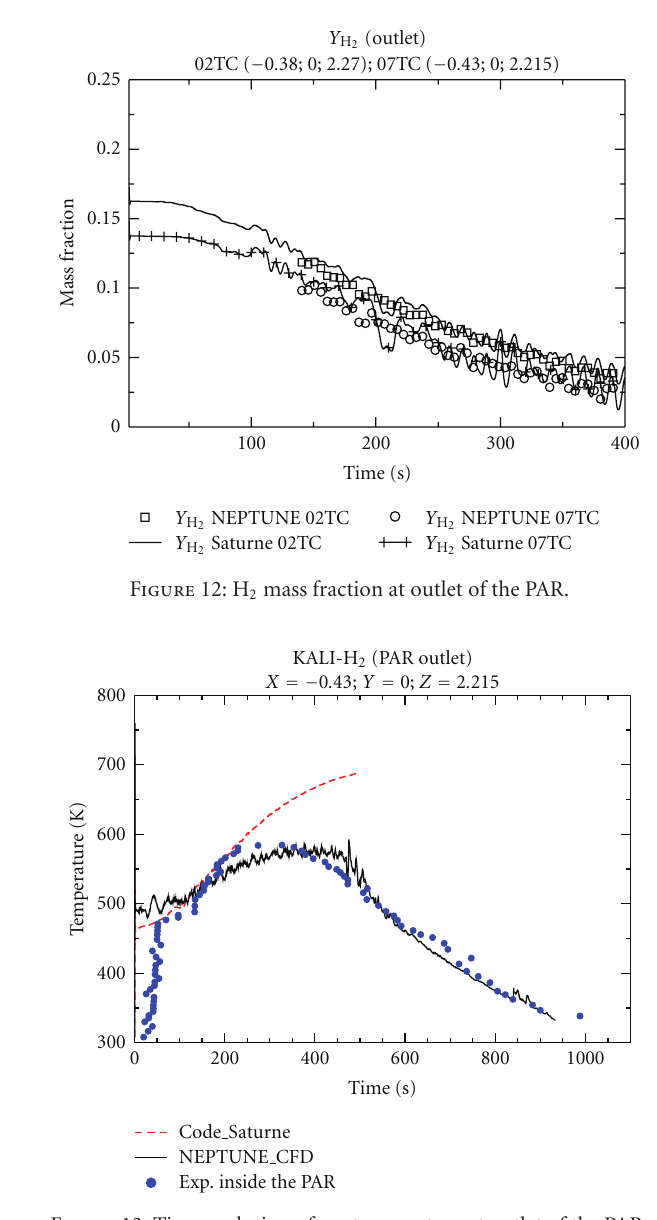
Figure 13: Time evolution of gas temperature at outlet of the